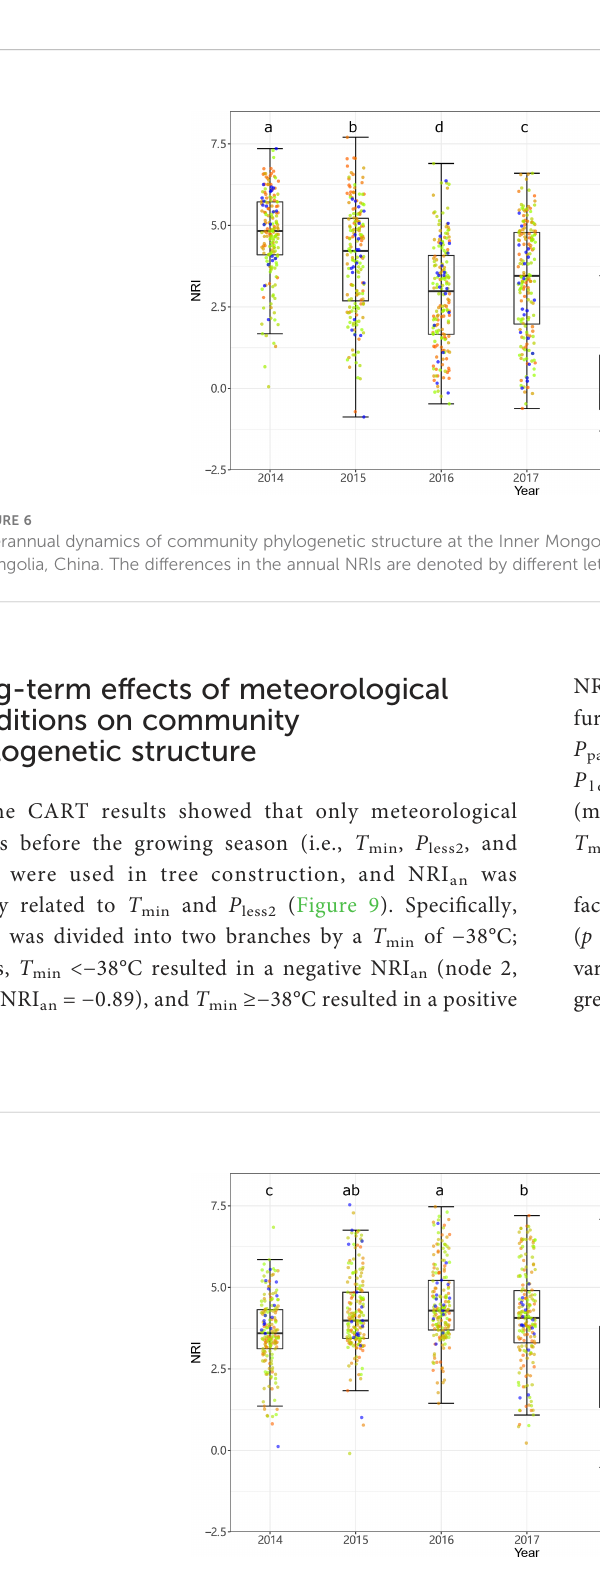
FIGURE 7 Interannual dynamics of community phylogenetic structure at the Xilinhot National Climate Observatory (NCO) in Inner Mongolia, China. The differences in the annual NRIs are denoted by different letters according to Duncan ’ s post hoc test ( p <